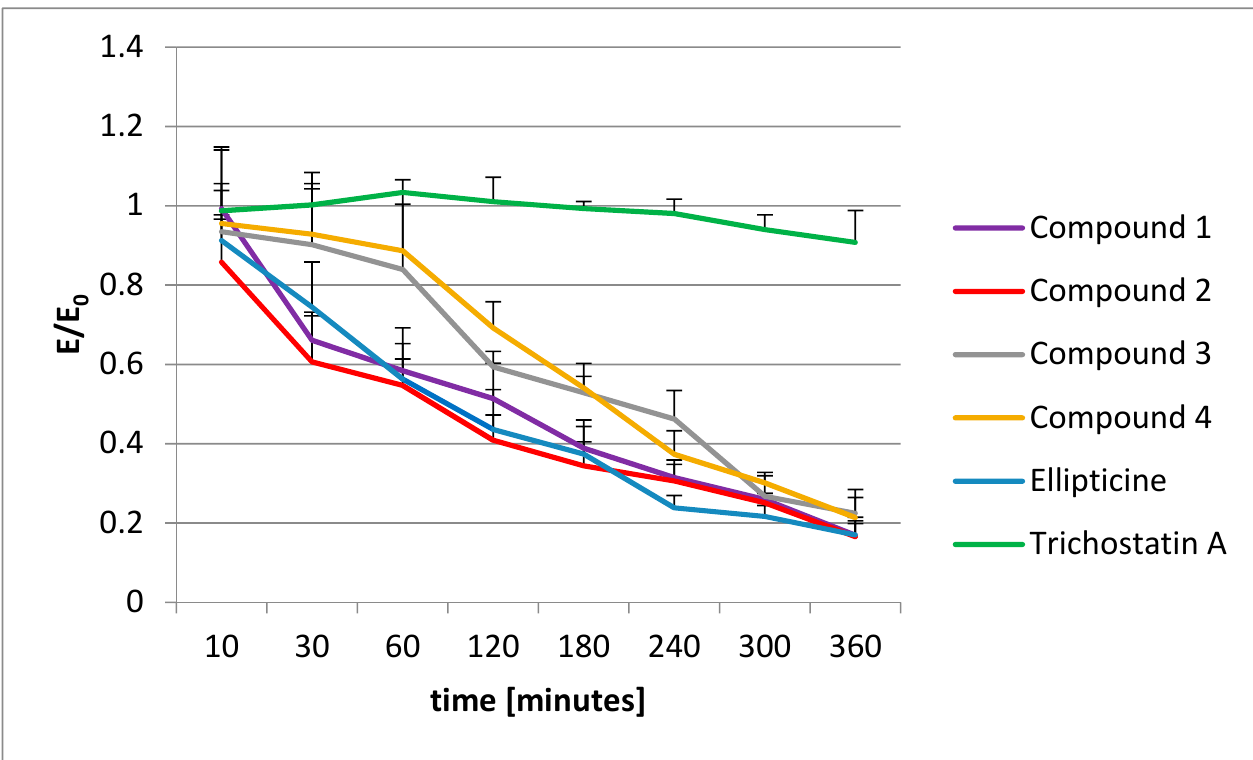
Figure 8 . The MTT assay performed for studied pyridocarbazoles (compounds 1 – 4 ), ellipticine, and trichostatin A. Concentration of all tested compounds was 10 µM. E/E 0 is the mean value in reference to the control (E 0 = control = 1).